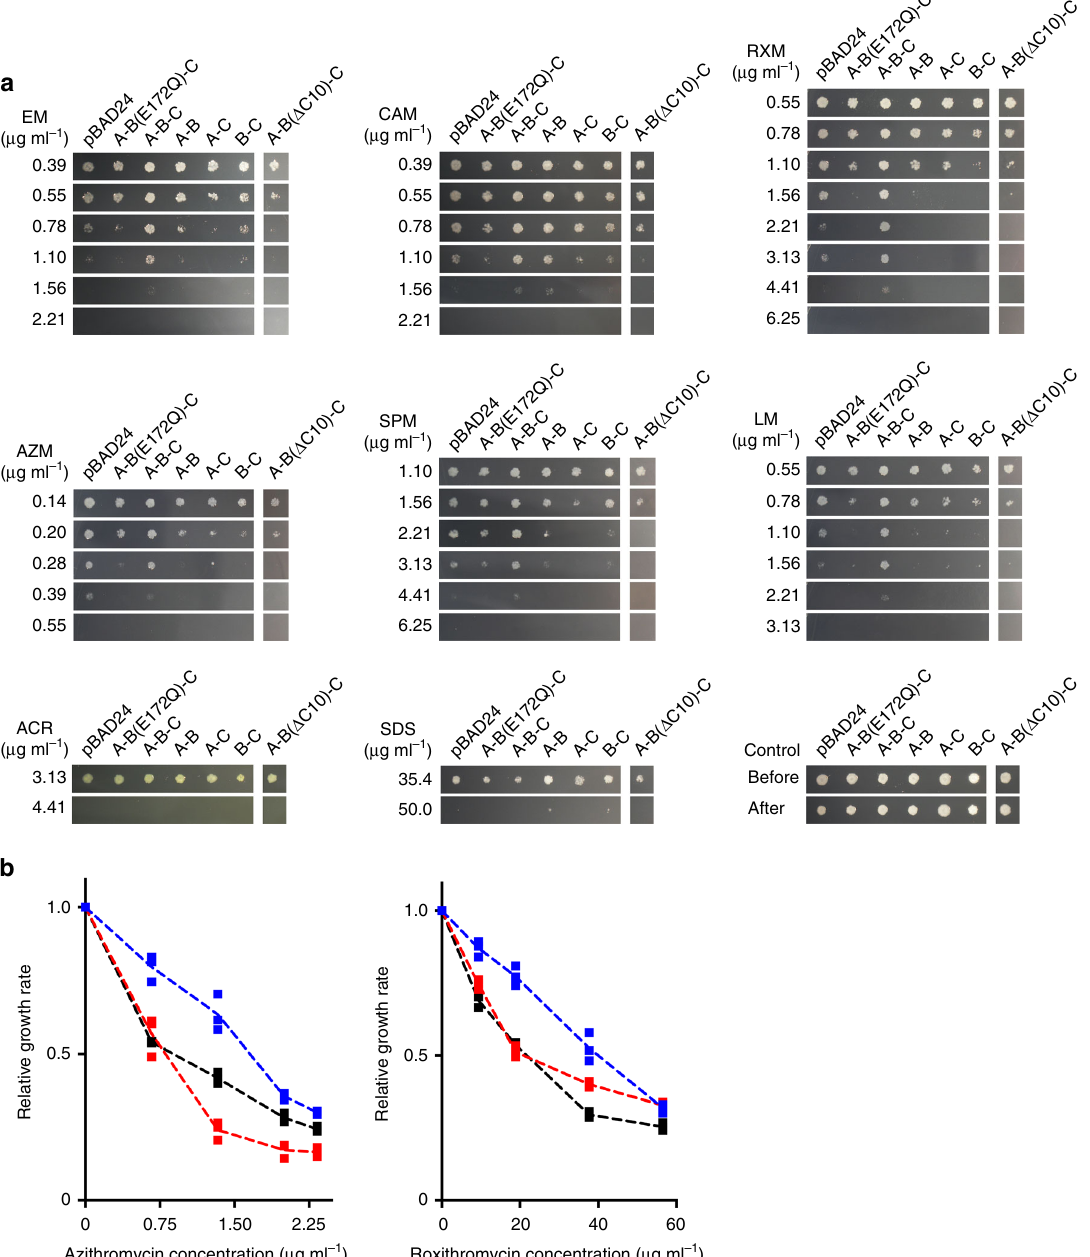
Fig. 1 Measurement of drug resistance of E. coli expressing A. baumannii MacA-MacB-TolC or transport inactive mutants. a Growth of E. coli expressing Acinetobacter MacAB-TolC, or combinations of components and mutants, in the presence of various macrolides and AcrB substrates. Data in Table 1 are based on the colony formation shown in this fi gure. A, MacA; B, native MacB; B(E172Q), transport-inactive E172Q MacB mutant; B( Δ C10), MacB lacking the carboxy terminal CH2; C, TolC. For MIC measurements, cells were grown on agar plates in the presence of dilutions of compounds. Abbreviations of drugs are the same as in Table 1. b Expression of MacA-MacB-TolC confers drug resistance on E. coli cells in liquid cultures. Relative growth rate of drug- sensitive E. coli W3104 Δ acr AB Δ mac AB harbouring empty pBAD vector (control), or pBAD containing macAB / tolC from A. baumannii (blue trace), or pBAD with macA / tolC only (inactive; red trace) in the presence of (left) 0 – 2.3 µ g ml − 1 azithromycin or (right) 0 – 56.4 µ g ml − 1 roxithromycin. IC 50 values are summarized in Table 2. Each measurement was repeated three